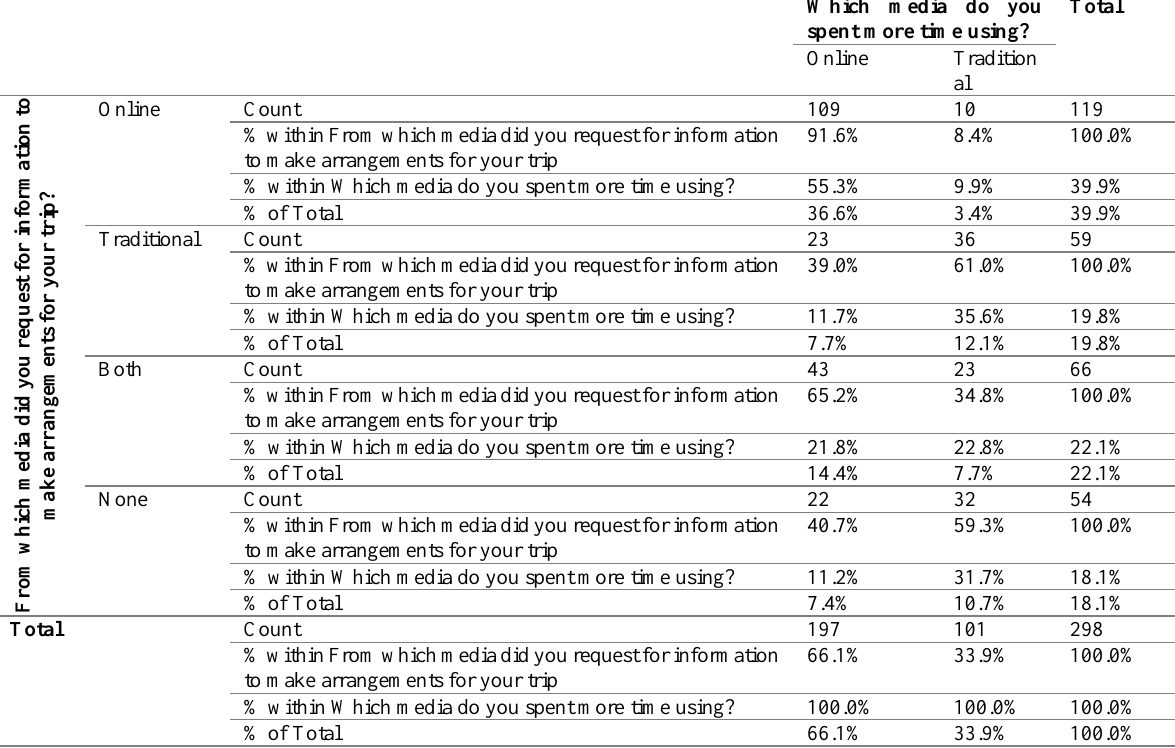
Table 7: Media used to request information for the trip